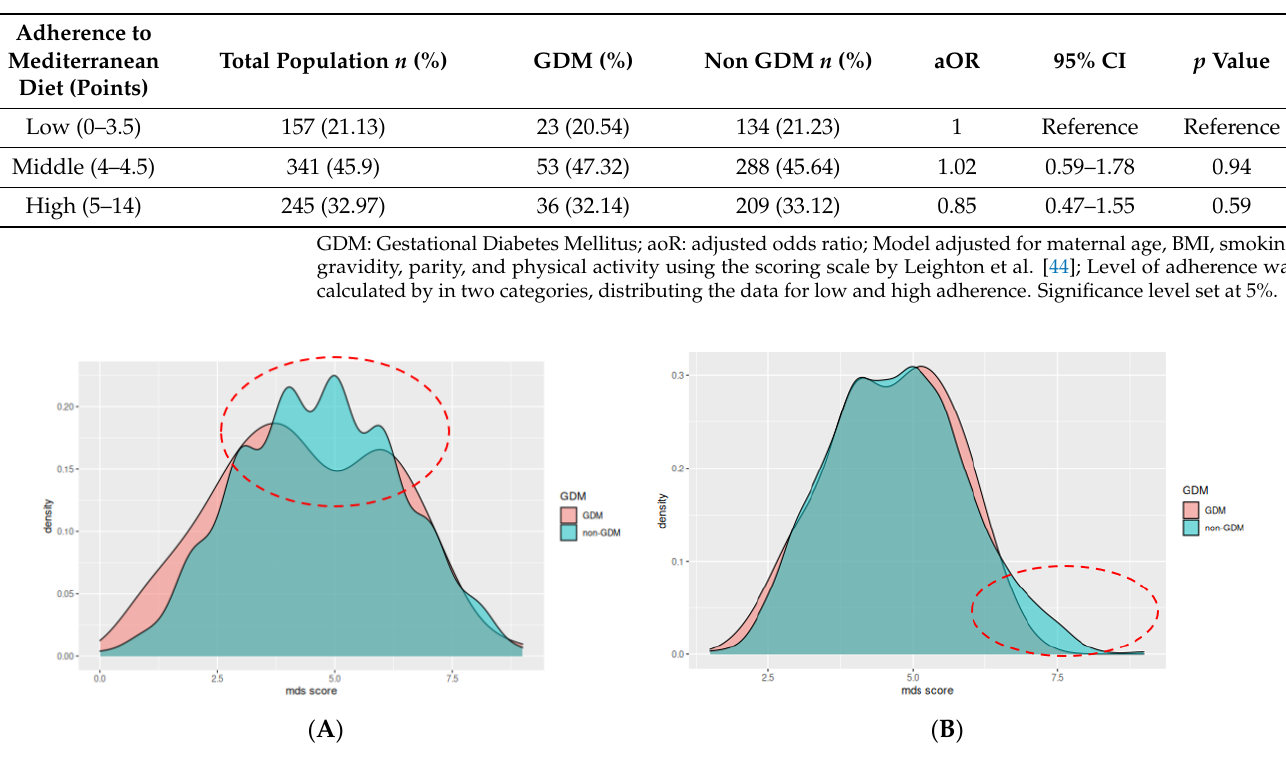
Figure 2. Mediterranean diet index score ( A ) and modified Mediterranean Diet Score ( B ) between the two groups, GDM: Gestational Diabetes Mellitus; MDS score: Mediterranean Diet Score. The main differences are highlighted in the red dotted ellipsoids, were the adherence of the non-GDM group is higher compared to the GDM group.